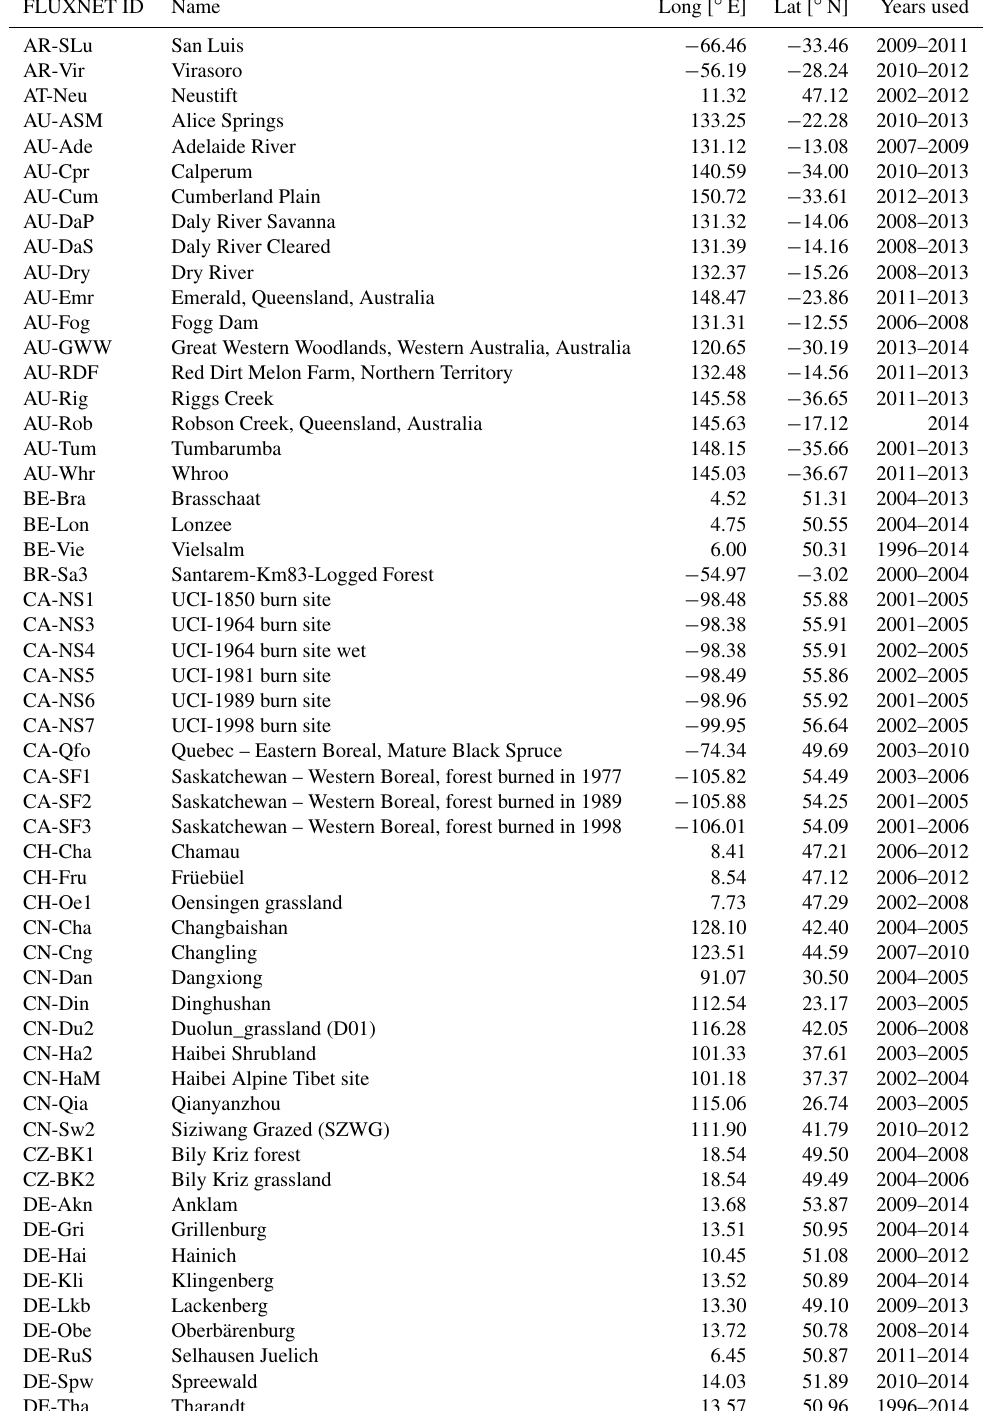
Table B1. Overview of FLUXNET Tier 1 v1 stations within the period